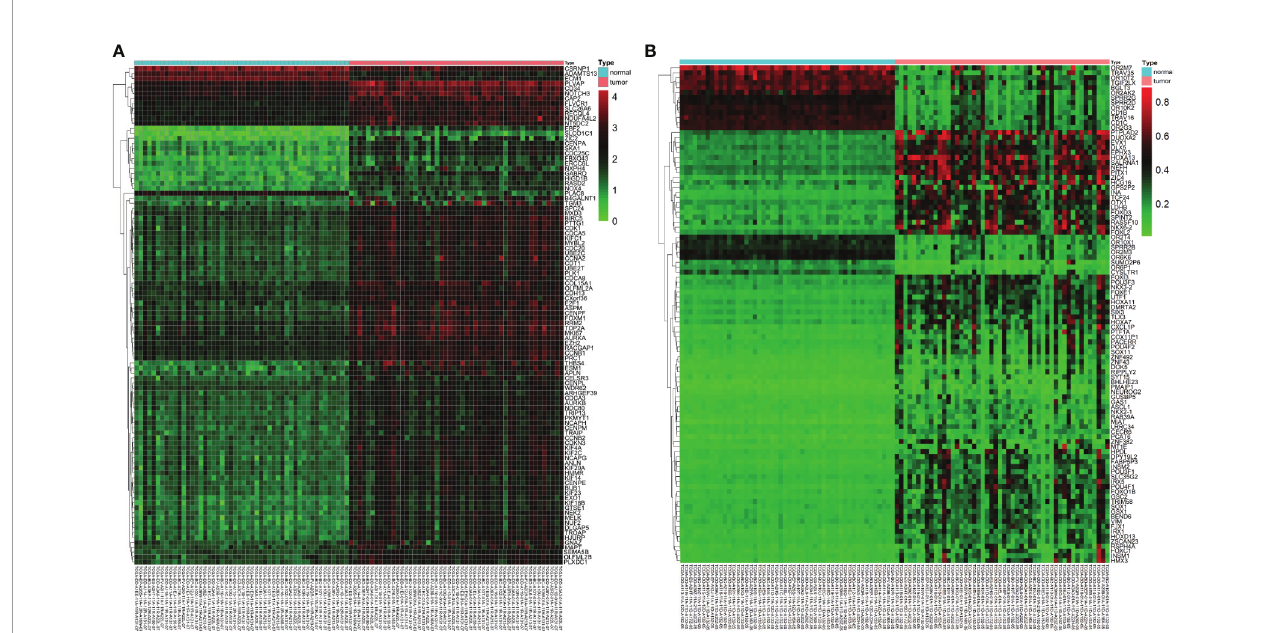
FIGURE 1 | Differentially expressed genes (DEGs) and differentially methylated genes (DMGs) identi fi ed from The Cancer Genome Atlas (TCGA) database. (A) Heat map of the top 100 DEGs (log 2 FC > 2, P < 0.01). Lower horizontal axis marks sample names, left vertical axis shows clusters of DEGs, and right vertical axis represents gene names. Red represents up-regulated genes and green represents down-regulated genes. (B) Heat map of the top 100 DMGs (log 2 FC > 1, P < 0.01). Lower horizontal axis marks sample names, left vertical axis shows clusters of DMGs, and right vertical axis represents gene names. Red represents hypermethylated genes and green represents hypomethylated